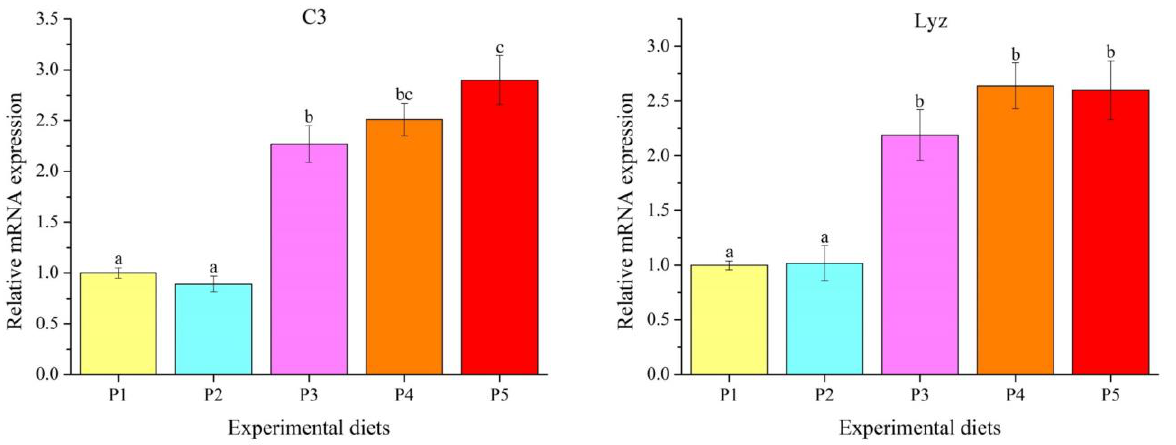
Figure 6. The mRNA levels of immune-related genes in the livers of Oncorhynchus mykiss fed experimental diets. Values are presented as mean ± SE, n = 4. Means with different superscripts are significantly different ( p < 0.05). C3: ANOVA, 0.000; linear, 0.000; quadratic, 0.000. Lyz: ANOVA, 0.000; linear, 0.000; quadratic, 0.000.